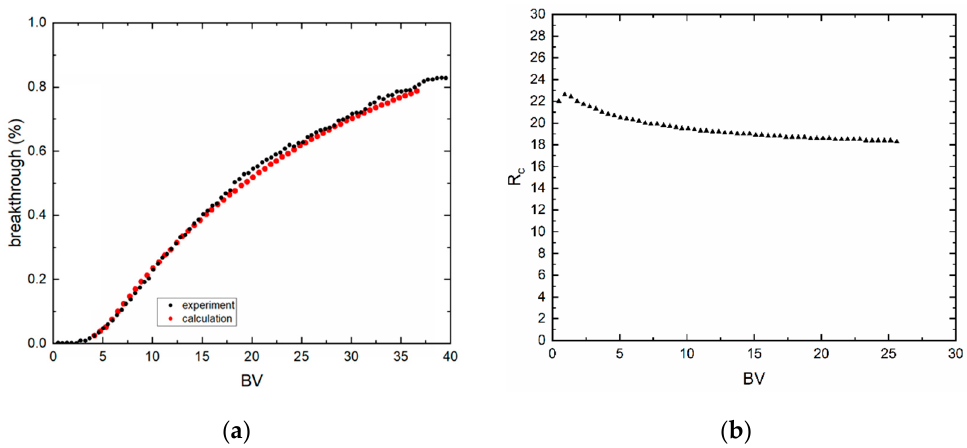
Figure 8. Breakthrough curve of ( a ) BC1, 0.3437 g, pH 2, c ( NH 4 ReO 4 ) = 10 − 3 mol·dm − 3 , u = 4.5 BV·h − 1 . ( b ) Retardation coefficient ( R c ) as a function of BV.